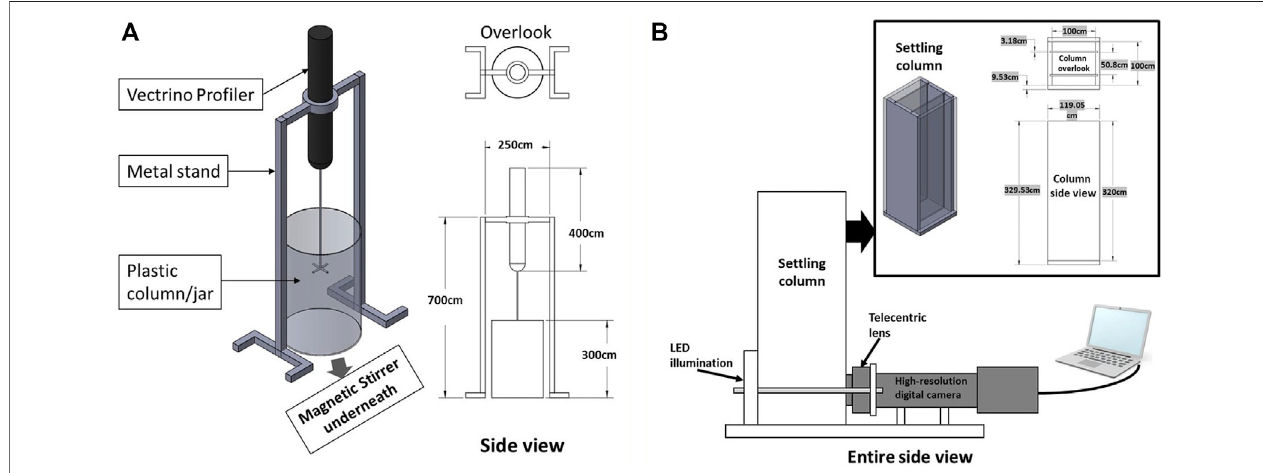
FIGURE 3 | Schematic of the laboratory setup to test the in fl uence of EPS on fl occulation. Panel (A) shows the self-designed Vectrino stand and panel (B) shows the LabSFLOC-2 system.